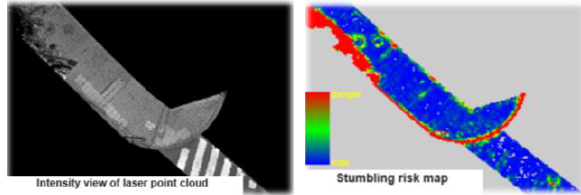
Figure 13. Application of the developed trolley-loading system utilized in generation of a road hazard map